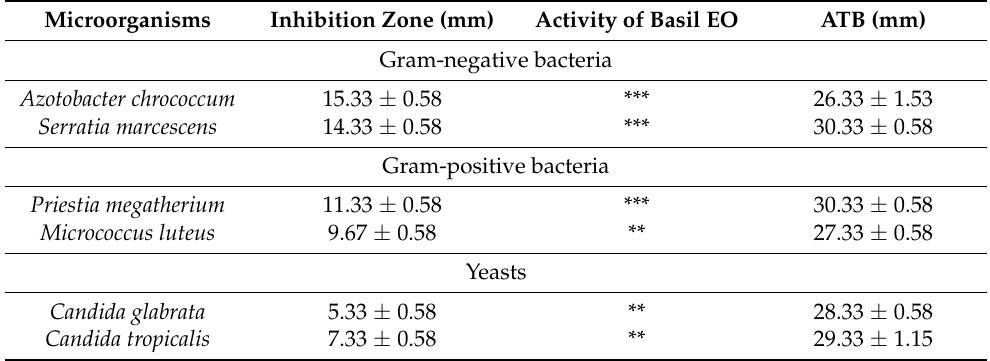
Table 2. In vitro analysis of the antimicrobial activity of the OBEO with disc diffusion method.